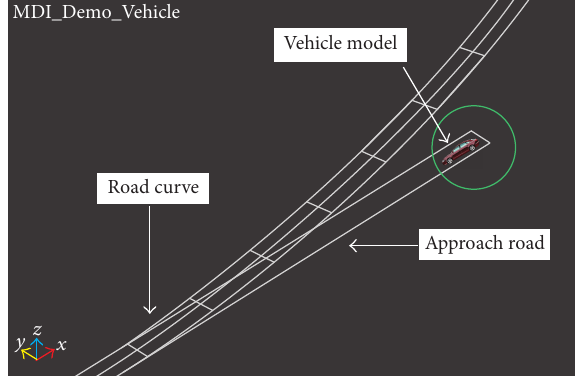
Figure 4: Driver-vehicle-road simulation system.